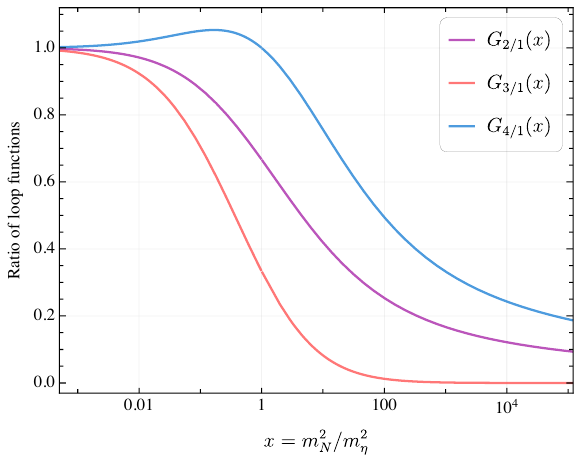
Figure 1 . Ratios of loop functions associated with LNV dim-5 and dim-7 matching coefficients as a function of the mass squared ratio x